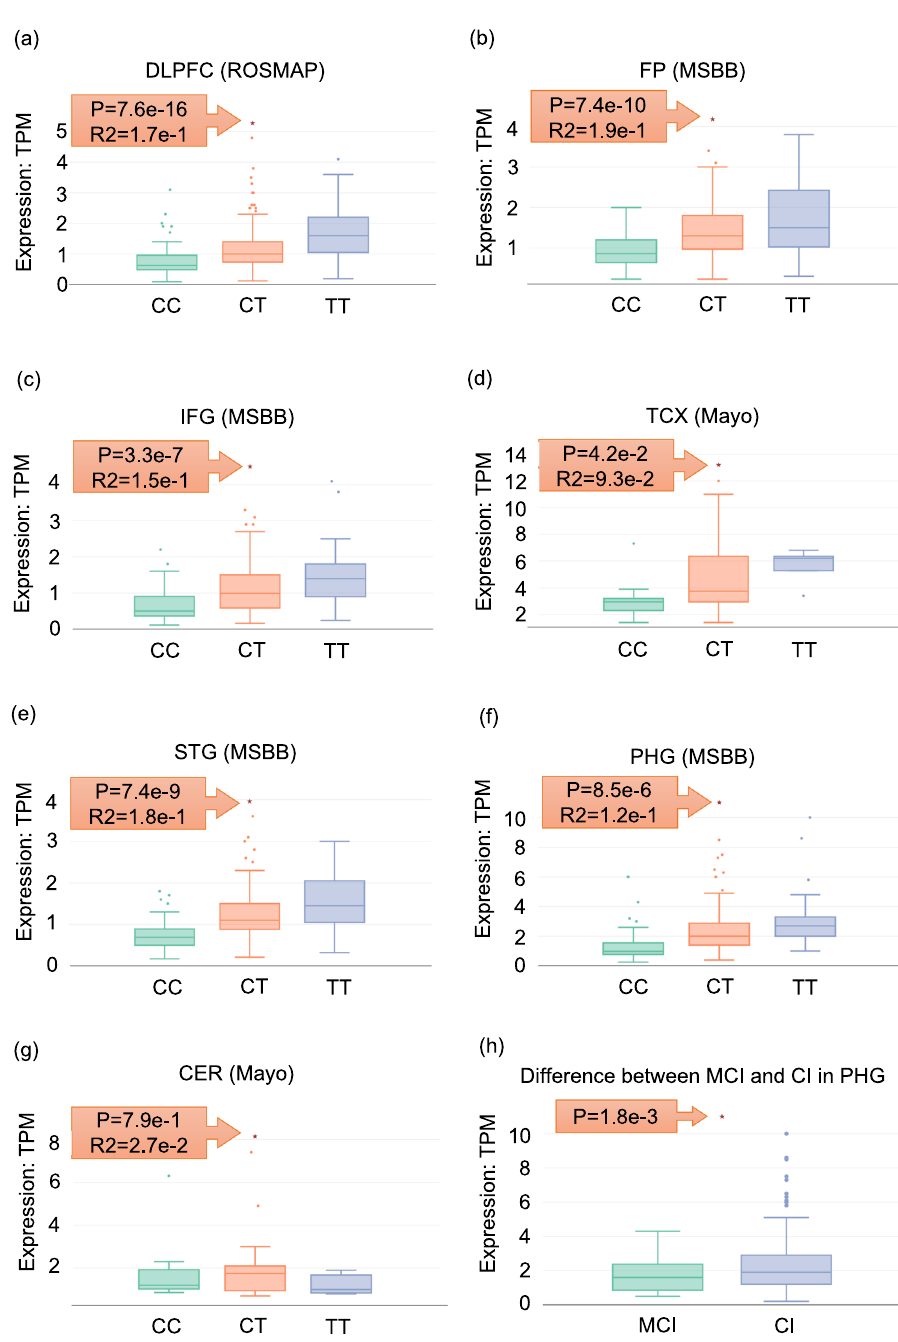
Fig. 7 An eQTL association for rs1324551 of FAS . a – g Expression distribution of ENST00000355740 according to rs1324551 genotype in seven brain regions of AD patients. h Differential expression of ENST00000355740 in the PHG between AD patients with mild cognitive impairment (MCI) and severe cognitive impairment